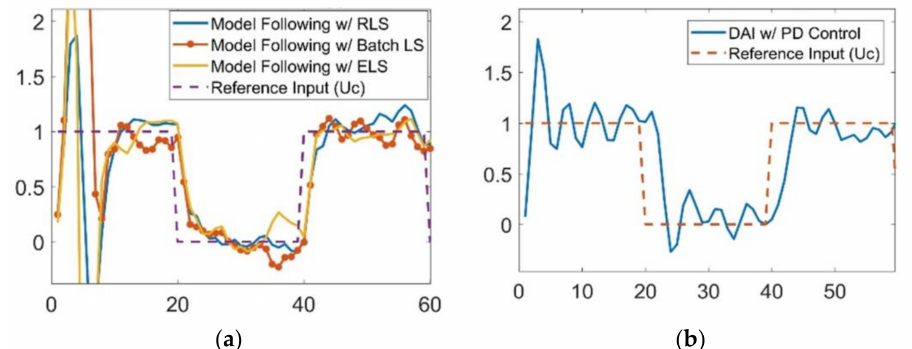
Figure 6. Results based on discretization of plant using difference equations in Equation (2) ( a ) Input tracking with model-following and parameter estimation on ordinate with time in seconds on the abscissa. ( b ) Input tracking with deterministic artificial intelligence and proportional plus derivative adaption of self-awareness statements on ordinate with time in seconds on the